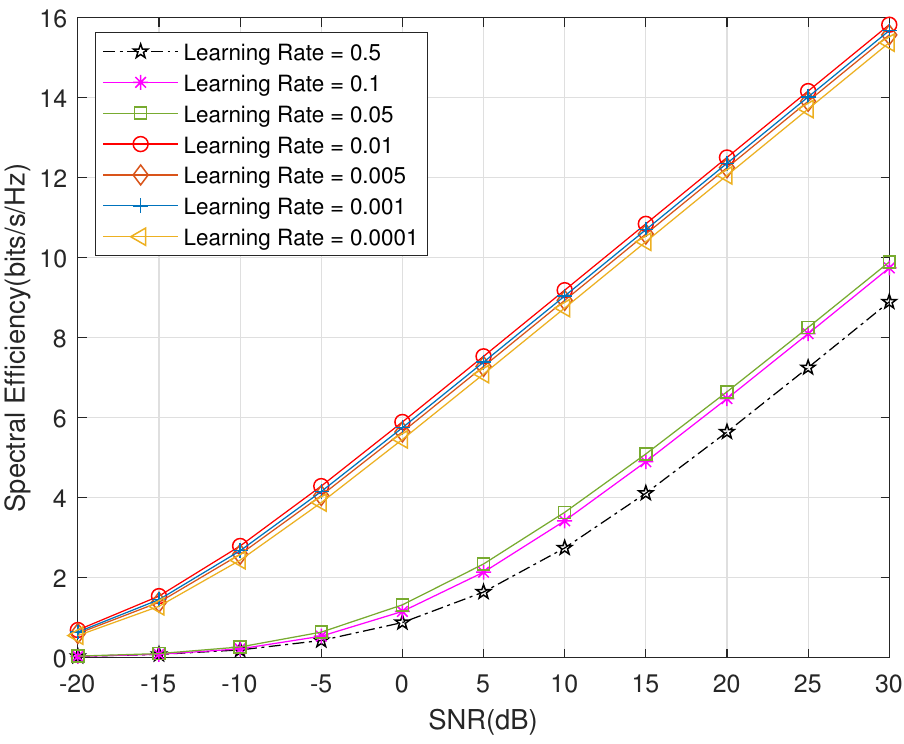
Figure 5. Spectral efficiency performance versus SNR of the proposed scheme under various learning rates in geometric mmWave channel with N t =